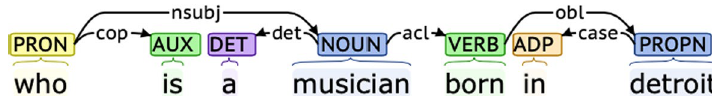
Fig. 8 Example of UDP extraction of a